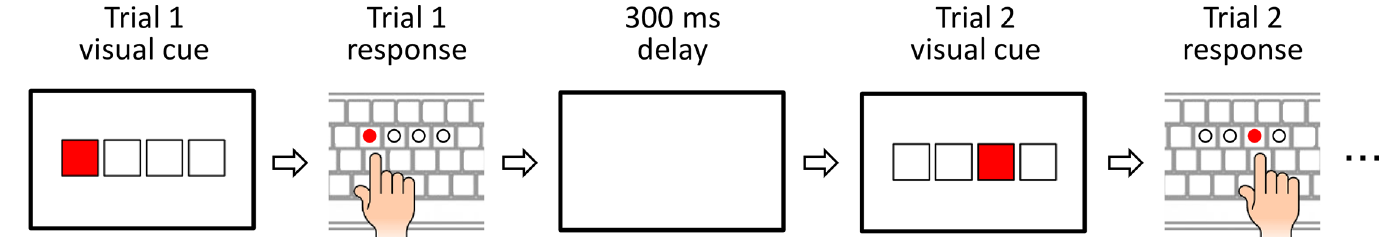
Fig 1. Schematic representation of the SRT task. In each trial, the visual cue appears and the participant responds by selecting the appropriate response on the keyboard. The cue then disappears, ending the trial and, following a fixed delay, another visual cue marks the beginning of a new trial. In the current study, there were 12 trials per sequence, 9 sequences per block, and 8 blocks, of which the first 6 used a repeating sequence, the 7 th used a random interference sequence, and the 8 th returned to the original repeating sequence